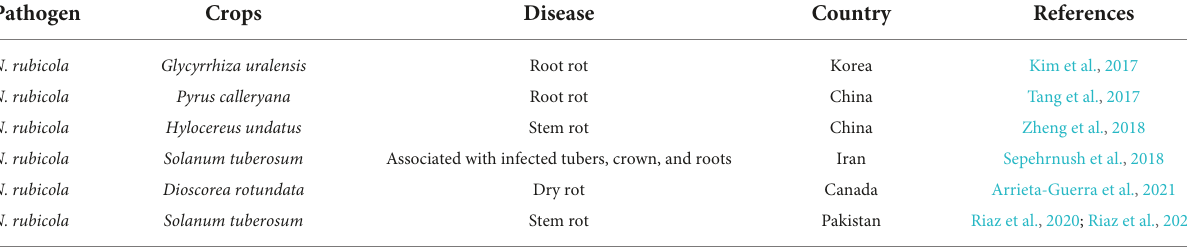
TABLE 3 Global distribution of Neocosmospora rubicola and their host plants.